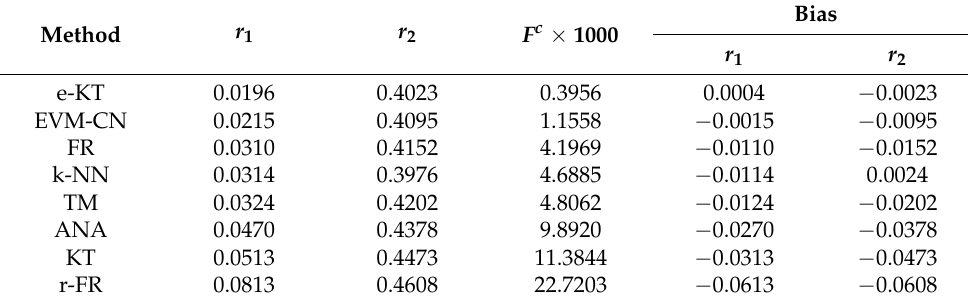
Table 15. Reactivity ratios obtained in the imposed conditions of MC1.